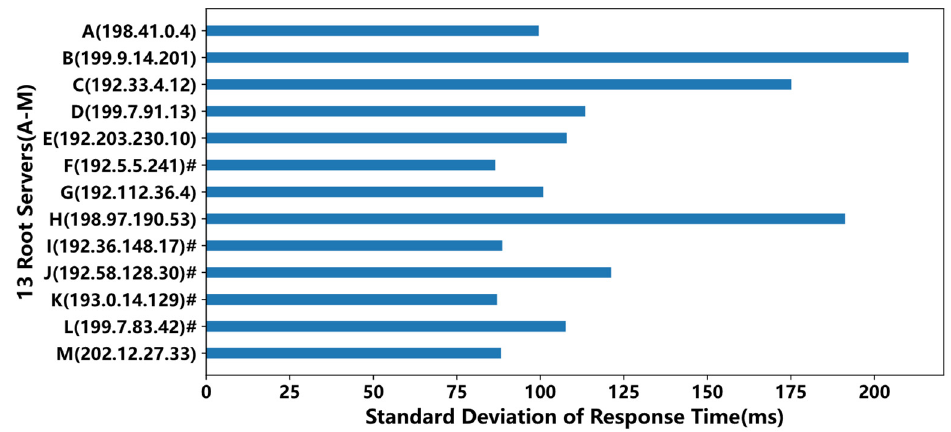
Figure 6. The standard deviations of overall average response times. The root marked with ”#” indicates its mirror nodes have been deployed in China.